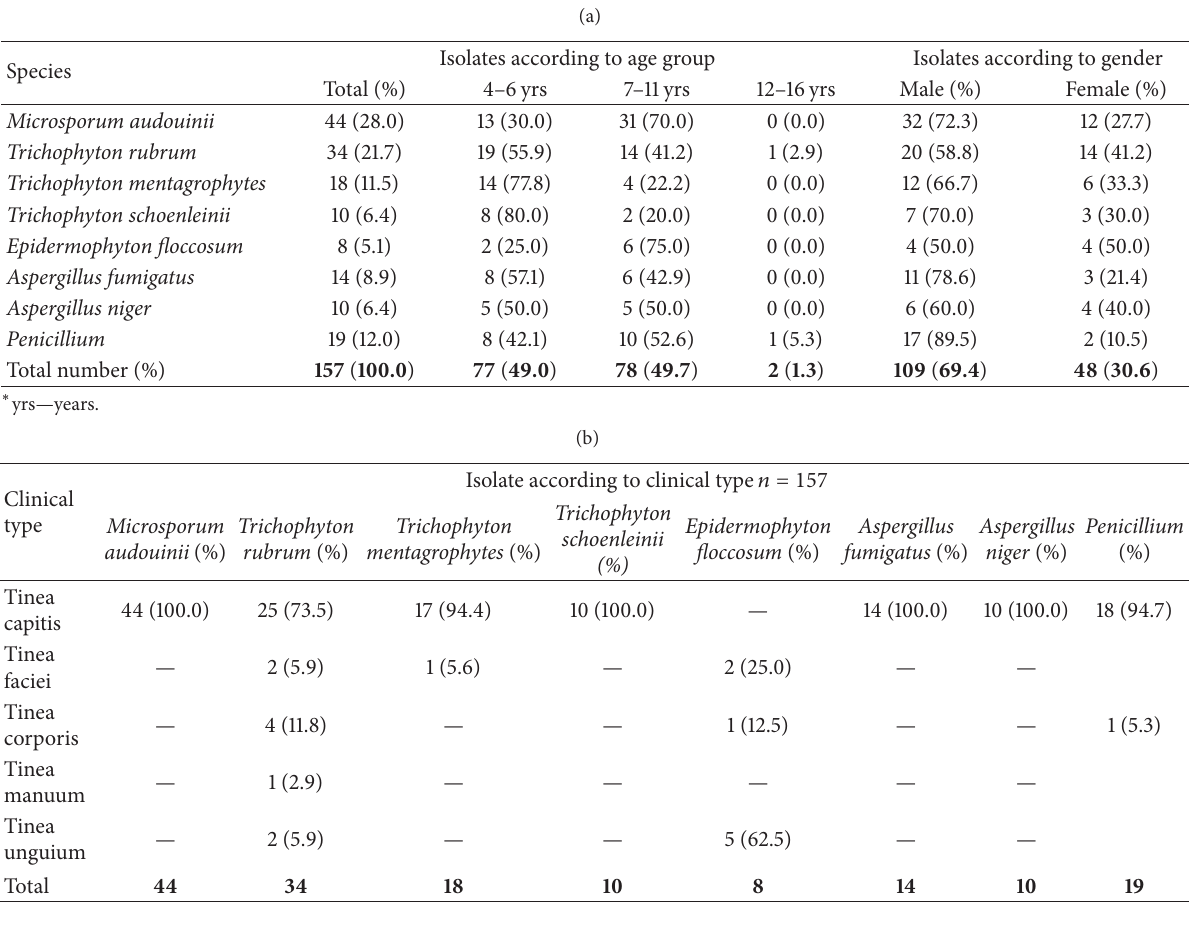
Table 4: (a) Distribution of dermatophytic isolates according to age and gender grouping of primary pupils in Ile-Ife ( 𝑛 = 157 ). (b) Distri- bution of dermatophytic isolates according to clinical